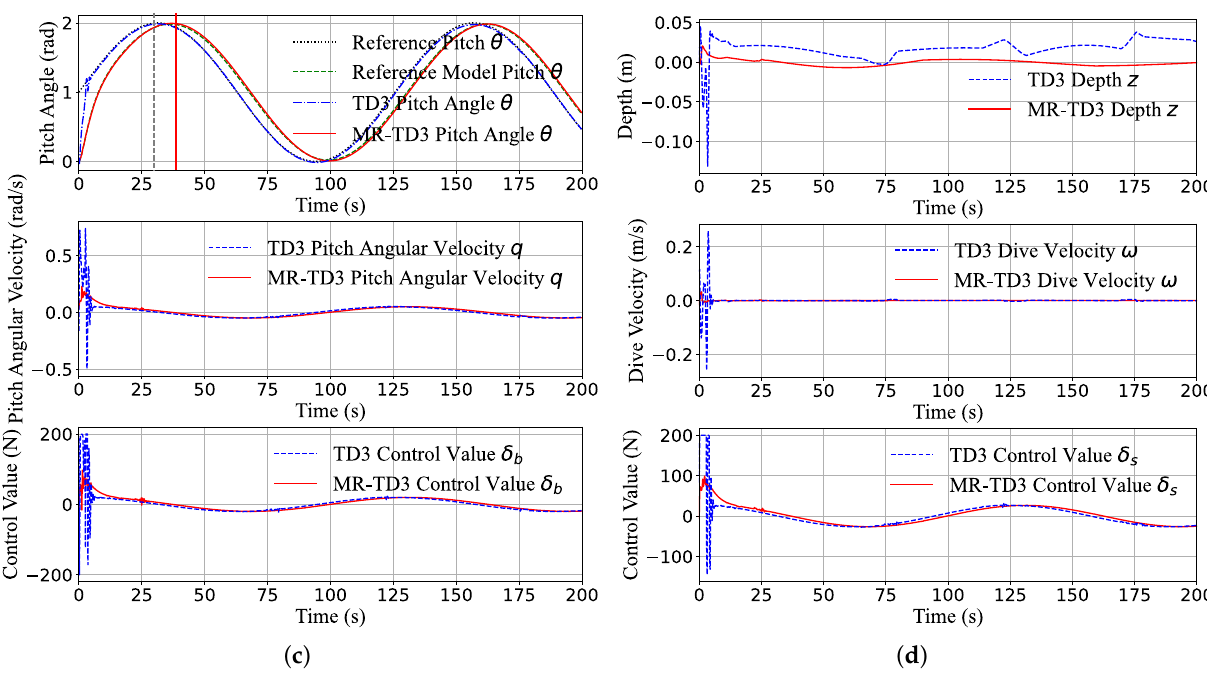
Figure 9. The pitch channel transition of the system states (pitch angle, pitch angular velocity, z- position, dive velocity) and control command during the step response ( a , b ) and sine wave response ( c , d ). The maximum actuator command is 200 N ; it can be seen that the TD3 method tends to provide a full control command, which is unacceptable in real machines. In contrast, the MR-TD3 command is smoother and can eliminate the overshoot significantly.